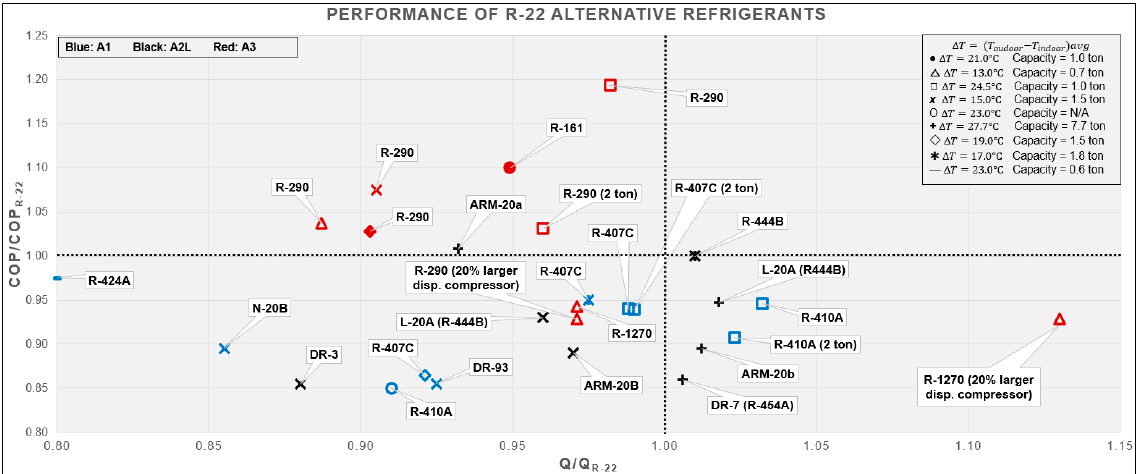
Figure 8. Experimental results for R-22 alternative refrigerants at HAT conditions, where Q is cooling capacity.